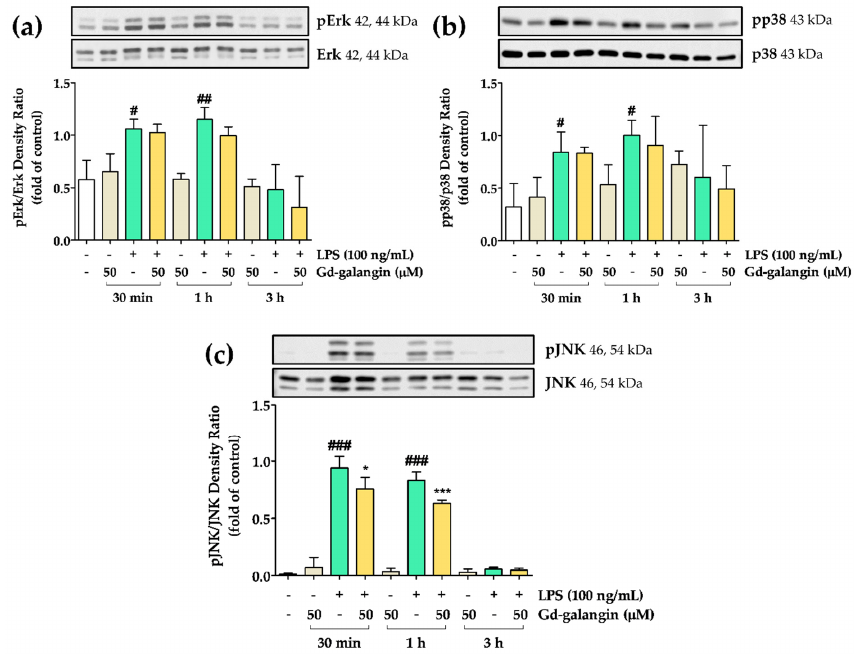
Figure 10. Effects of Gd-galangin on mitogen-activated protein kinase (MAPK) signaling pathway. (a, b) Gd-galangin had no effect on inhibiting phosphorylated Erk and p38. ( c ) Shows significant inhibition of phosphorylated p-c-Jun N -terminal kinase (JNK) by Gd-galangin. (Data are shown as the mean ± SEM, t -test, n ≥ 3. # p < 0.05, ## p < 0.01, ### p < 0.001 compared to control group; * p < 0.05, *** p < 0.001 compared to LPS-stimulated group.).